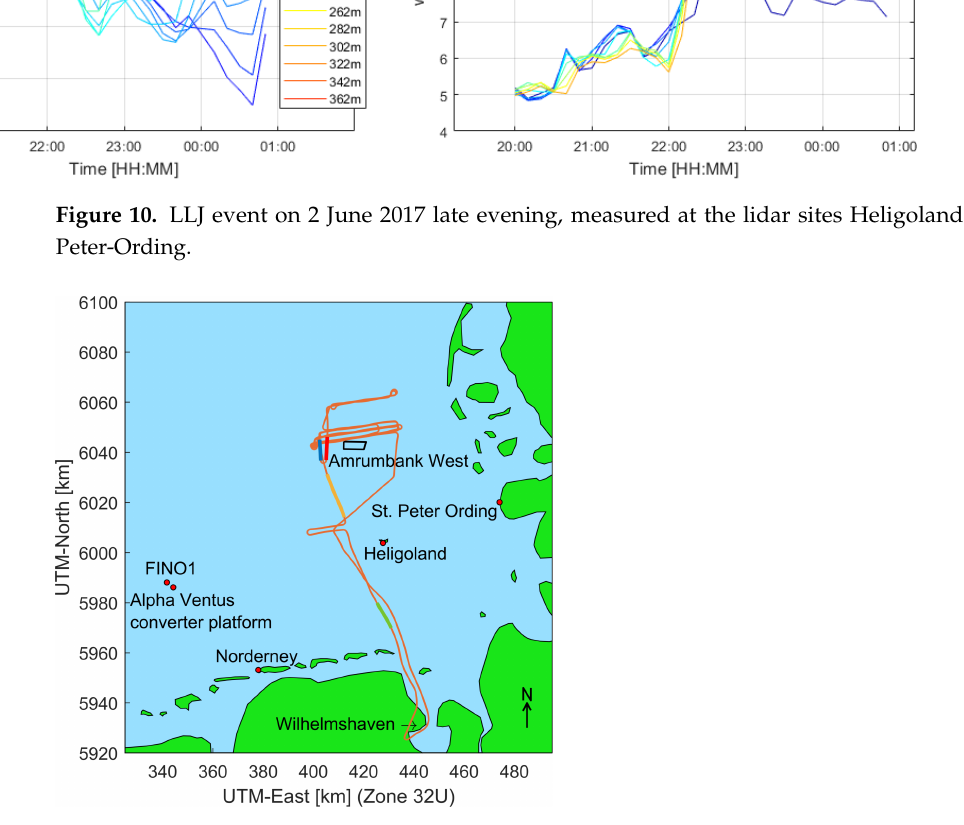
Figure 11. Flight track of the research aircraft on 2 June 2017. The coloured parts of the flight track indicate the location of the vertical profiles of wind speed and potential temperature that were used for model validation (Figure 12). The main purpose of the flight was to examine the flow situation around Amrumbank West wind